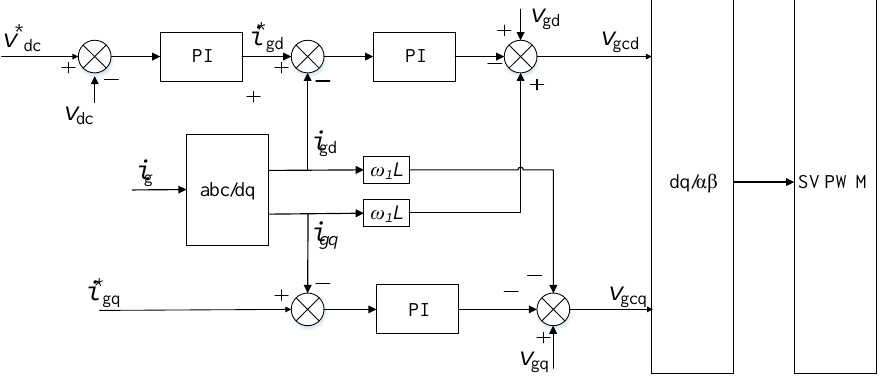
Figure 3. The control diagram of the GSC.